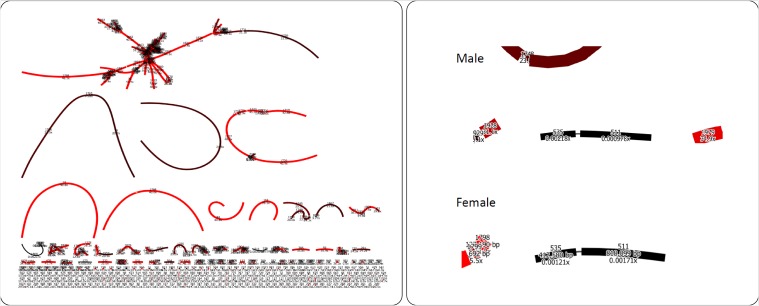
Bandage plot of a typical Drosophila genome assembly.The left panel is a visualization of the genome graph (.gfa file) from a canu assembly with the node name for each contig and Illumina coverage displayed in text overtop each contig. Each contig in the assembly is shaded by the amount of male Illumina whole genome sequencing coverage (see Materials and methods). In this example, red contigs are likely autosomal (~40×) while darker contigs have less coverage and indicate either putative sex chromosome contigs (~20×) or putative contaminant contigs (<<20×). (B) Shown is a zoomed in image of 2 nodes (535 and 511) in the assembly with exceptionally low male (top) and female (bottom) Illumina coverage (<0.1×). By also visualizing the top BLAST hits for these contigs (not shown), we were able to identify these contigs as belonging to an Acetobacter species and were thus contaminants marked for removal from the assembly. Contigs with exceptionally high Illumina coverage were also scrutinized thoroughly but these can arise for multiple reasons, including mtDNA contigs, collapsed regions of the target genome (e.g., rDNA genes or centromeric satellite sequence), or non-target contaminant contigs.